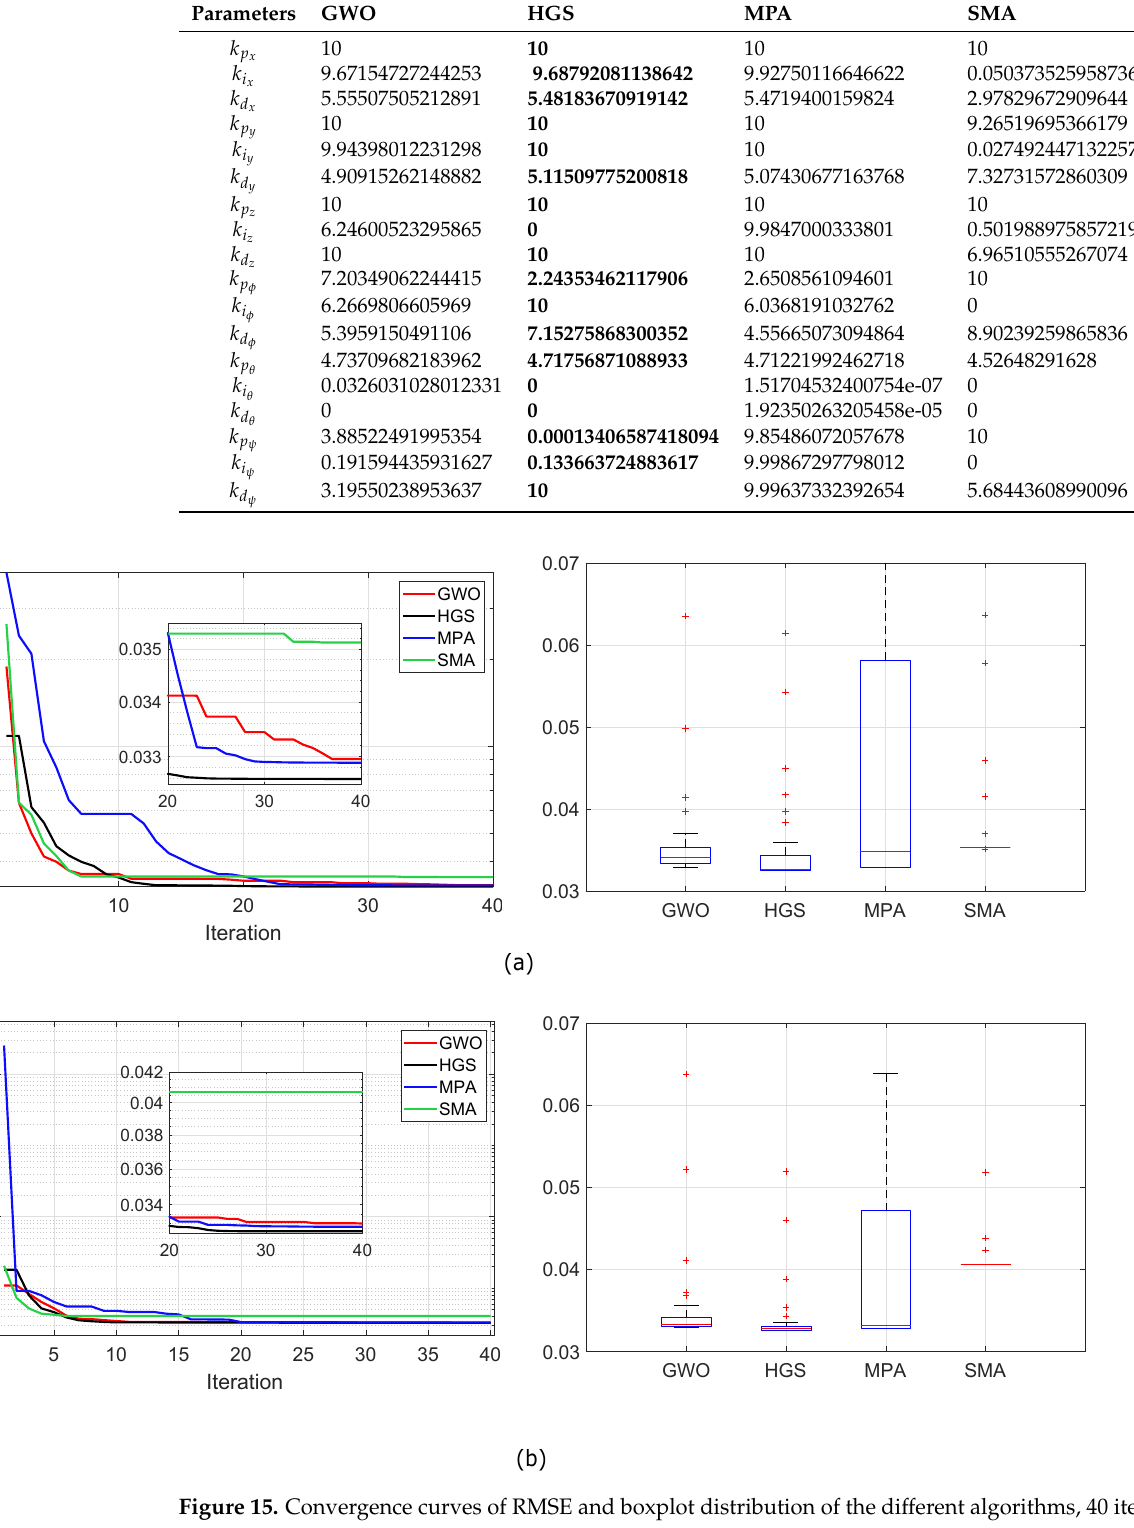
Table 10. The parameter estimation of metaheuristic algorithms with 100 individuals, 40 evolutions and 30 repetitions.